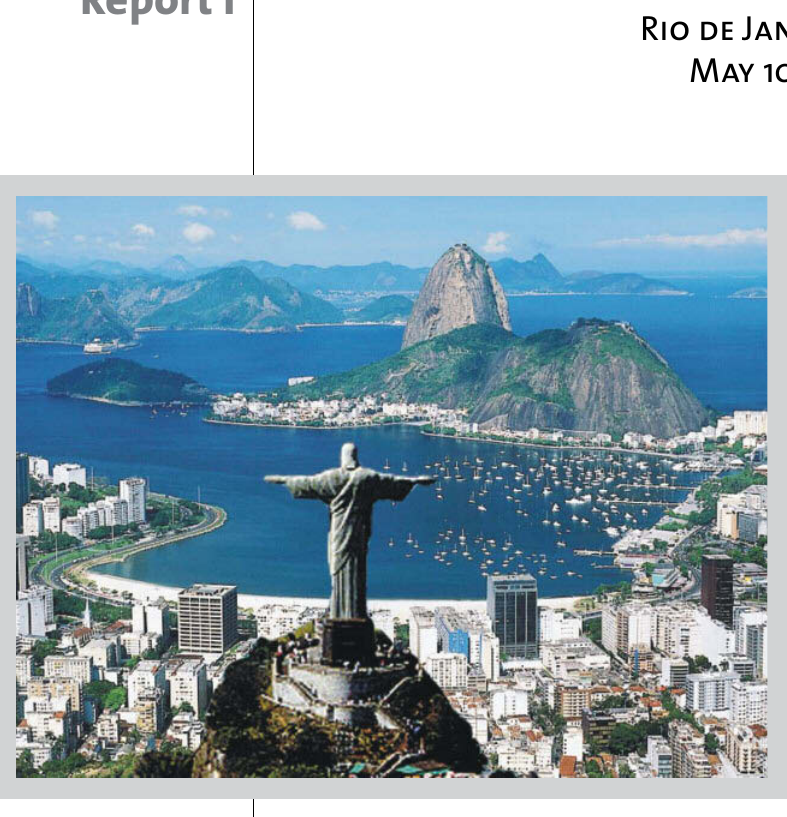
Figure 1 (above): Rio de Janeiro city, Brazil (cover of the proceedings). Figure 2: Photo of participants 1st Brazilian Congress of Rheo- logy (CBR